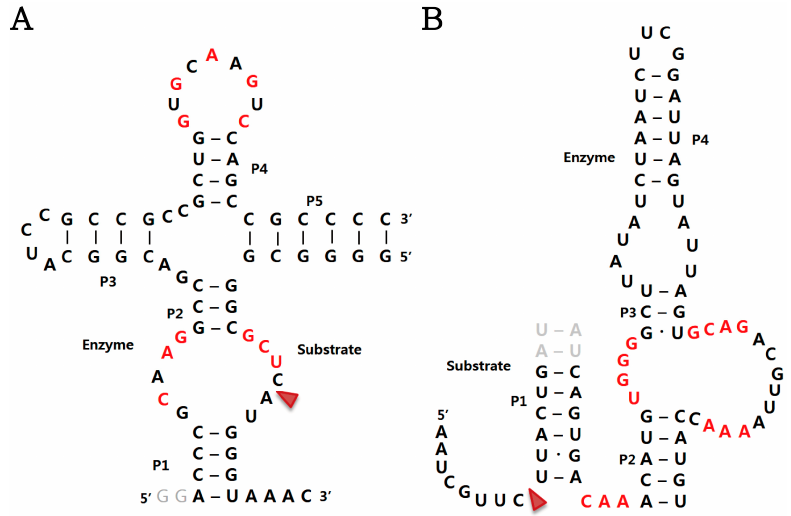
Figure 2. Sequence and secondary structure model of the TS-1 twister sister ribozyme [9] ( A ) and the Ht-1 hatchet ribozyme [11] ( B ). Highly conserved and non-native nucleotides are coloured in red and grey, respectively. The cleavage sites are indicated by red arrowheads.